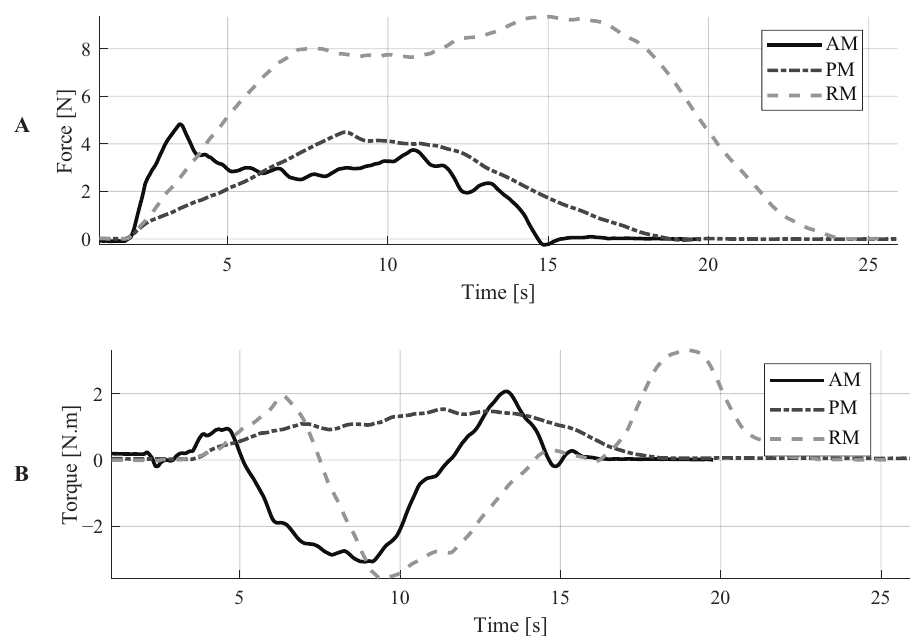
Figure 5. Illustration of force and torque signals for one subject: Assistance Mode (AM), Passive Mode (PM), Resistance Mode (RM).